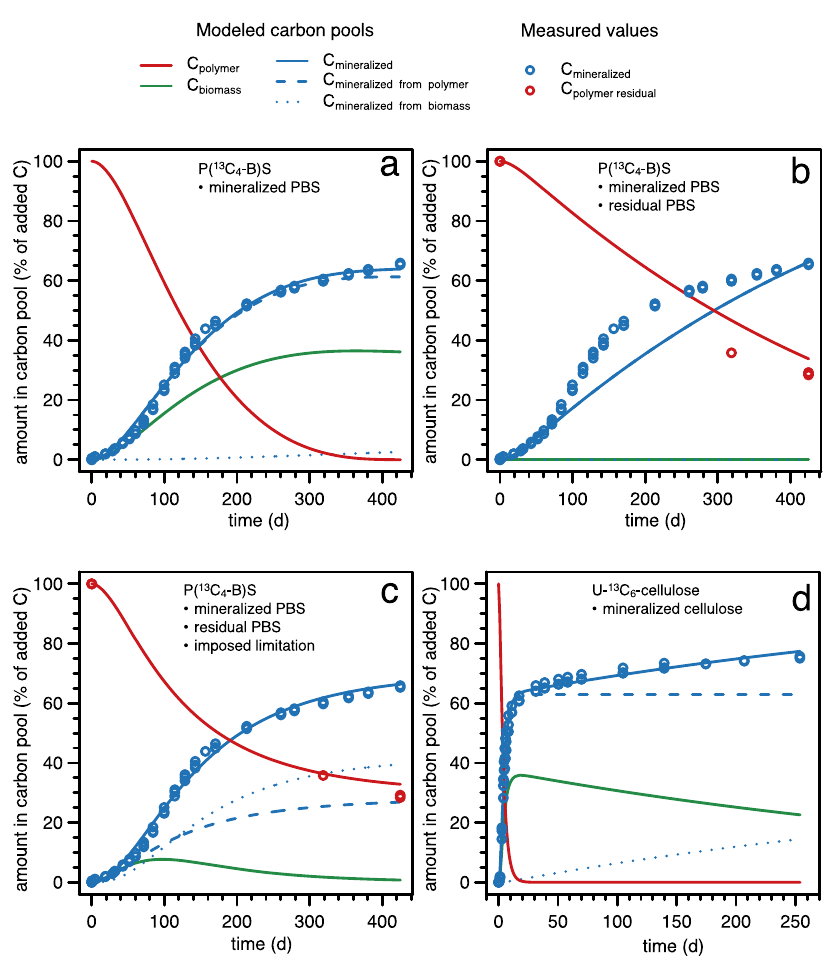
Fig. 5 | Kinetic modeling of poly(butylene succinate) (PBS) and cellulose bio- degradationdata. Experimentaldatafor PBSlabelledinbutanediol(i.e., (P( 13 C 4 -B) S; a – c )(opensymbolsinblue formineralizationand red forextracted PBS)and for cellulose ( d ; open symbols in blue for mineralization) is replotted from fi gures above. P( 13 C 4 -B)S model details and data are also given in the Supplementary Note7,alongwithmodeldetailsanddataoftheother 13 C-labelledPBSvariants.The solid,dashed,and dotted lines representthe modeled carbonpools asspeci fi ed in the fi gurelegend.ForPBS,threedifferentmodeltypeswererun:a fi rstmodelwhich